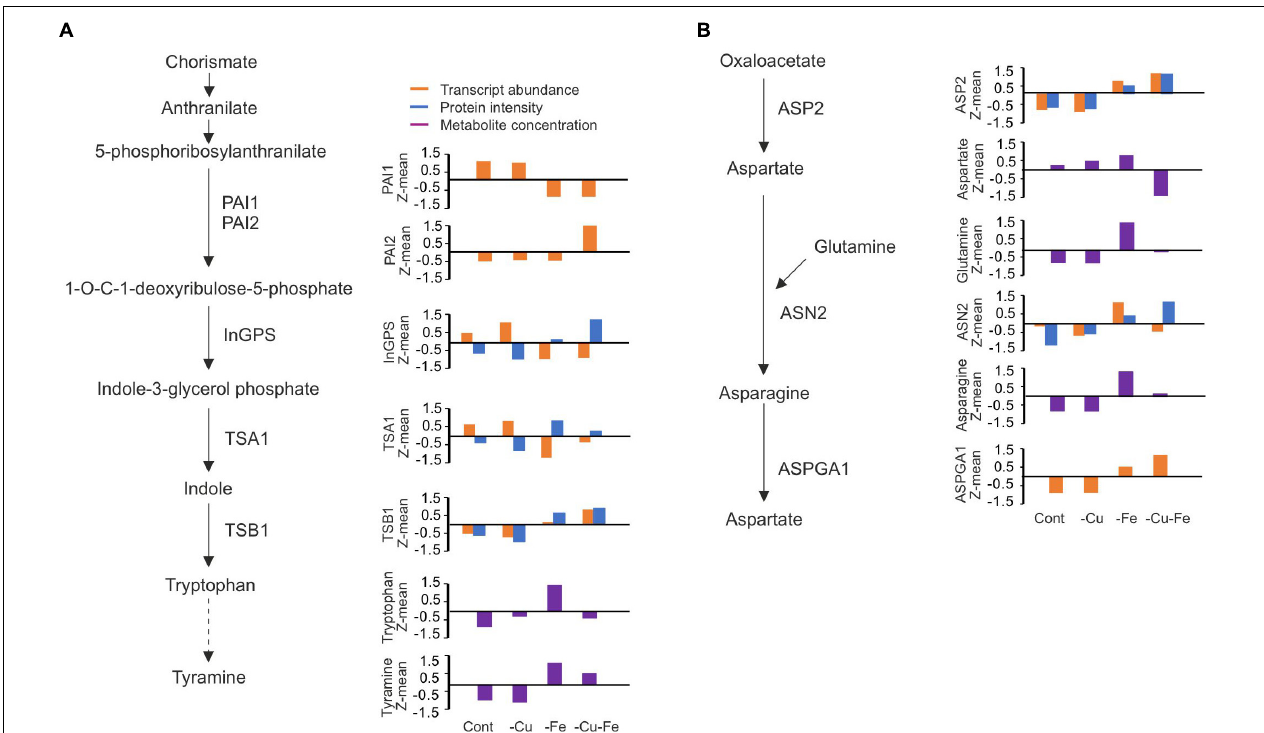
FIGURE 4 | Molecular changes in tryptophan and asparagine biosynthetic pathways in response to single and double deficiency of copper and iron. (A,B) Overview of the metabolic reactions involved in tryptophan (Trp, A ) and asparagine (Asn, B ) biosynthesis. Depicted are the metabolic intermediates and the enzymes catalyzing each of the reactions. Z-means of transcript counts (Fragments Per Kilobase Million, FPKM), proteins (LC-MS chromatography peak intensity), and metabolite (normalized concentration to 13 C-sorbitol and fresh weight) for each condition at 10 days, as reported in Garcia-Molina et al. (2020), were plotted. PAI1,2, PHOSPHORIBOSYLANTHRANILATE ISOMERASE 1 AND 2; InGPS, INDOLE-3-GLYCEROL PHOSPHATE SYNTHASE; TBS1, TRYPTOPHAN SYNTHASE BETA-SUBUNIT 1; TSA1, TRYPTOPHAN SYNTHASE A; ASP2, ASPARTATE AMINOTRANSFERASE 2; ASN2, ASPARAGINE SYNTHETASE 2; ASPGA1, L -ASPARAGINASE. TABLE 2 | Correlation among transcriptome, proteome and metabolome changes in the tryptophan and asparagine biosynthesis pathways. RNA Prot Trp (RNA/Prot) Tyramine (RNA/Prot) RNA Prot Asp (RNA/Prot) Gln (RNA/Prot) Asn (RNA/Prot) − 0.97 /NA ASP2 0.99 − 0.55/ − 0.65 0.67 /0.57 0.79 / 0.70 0.39/NA ASN2 0.22 0.48/ − 0.61 0.93 /0.54 0.86 / 0.67 ASPGA1 NA − 0.62/NA 0.60/NA 0.73 /NA